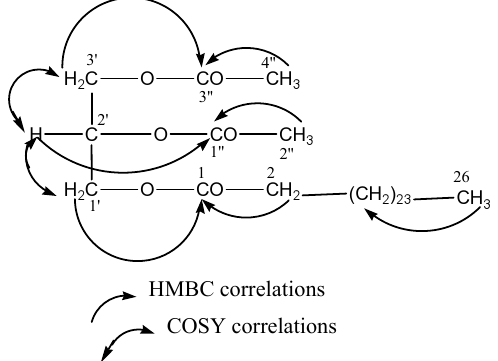
Figure 5. COSY and HMBC correlations for Cordicerol B. Table 1. Nuclear magnetic resonance (NMR) spectroscopic data (600 MHz for 1 H and 150 MHz for